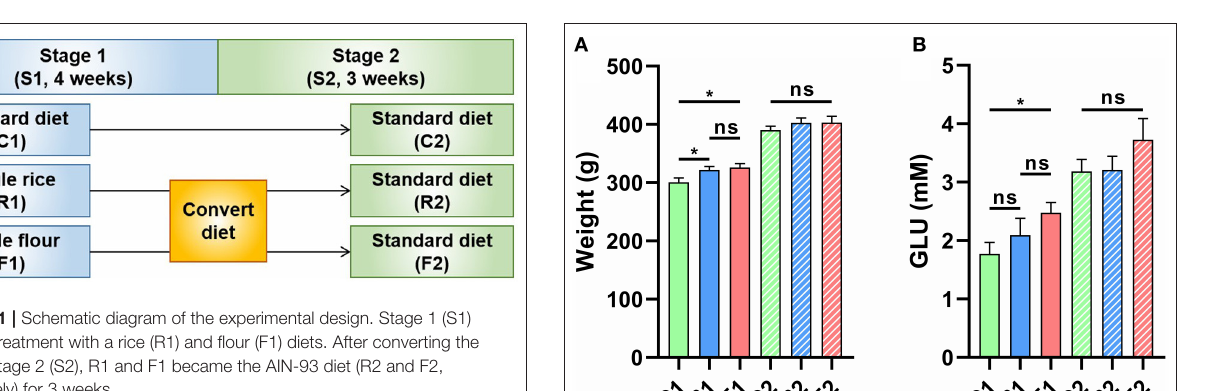
HSS T3 column (1.7 µ m; 100 mm × 2.1 mm) was used for